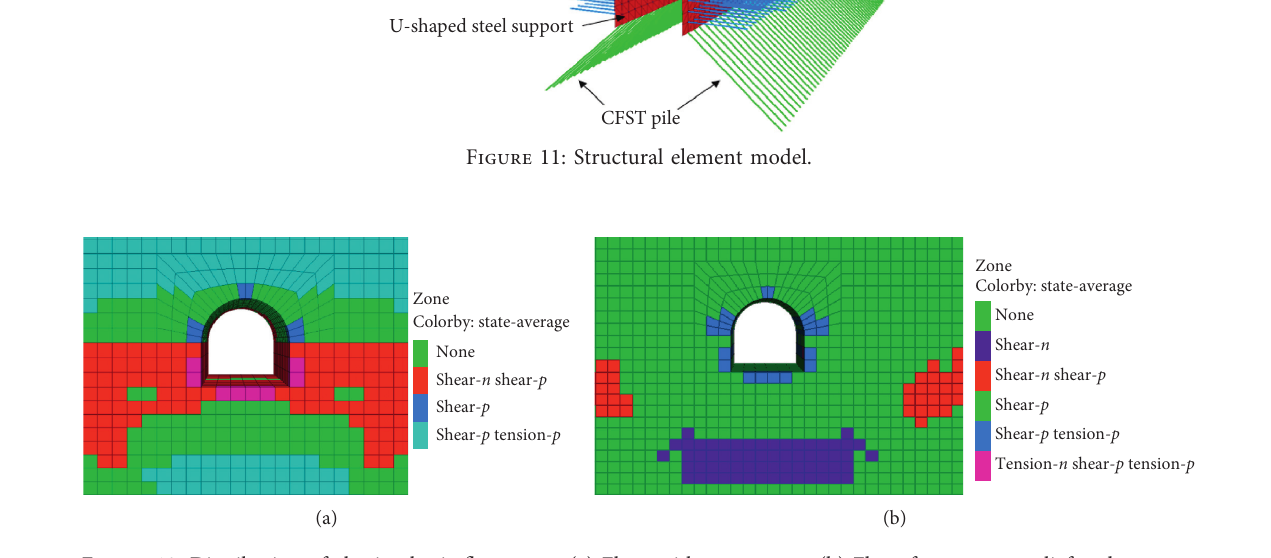
Figure 12: Distribution of elastic-plastic floor zone. (a) Floor without support. (b) Floor for pressure relief and support.